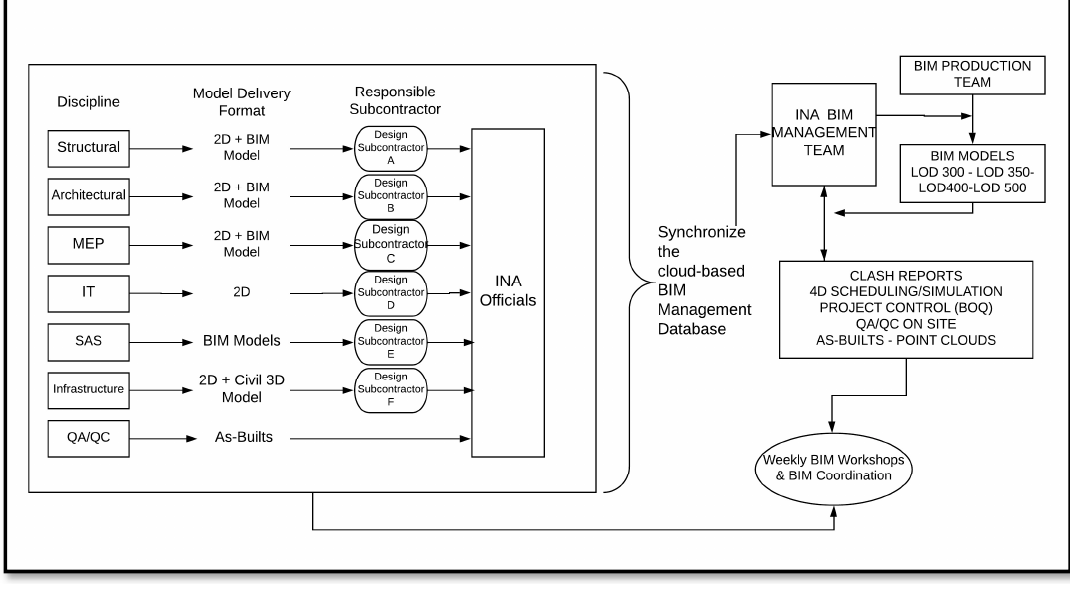
Figure 6. INA BIM Workflow (LOD: Level of Detail).